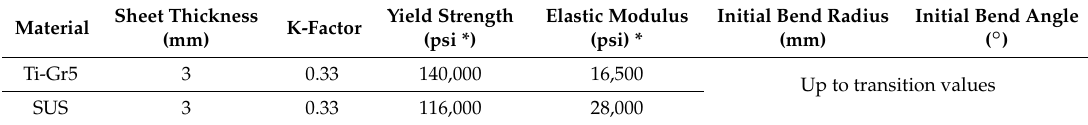
Figure 14. Bending Springback Calculator from CUSTOMPART.NET [23]; springback factor ( Ks ), final bend radius ( FR ), and final bend angle are changed by input values which are sheet thickness ( Mt ), K-factor, yield strength, elasticity, initial bend angle, and initial bend radius ( IR ). Table 7. Data of springback factors.